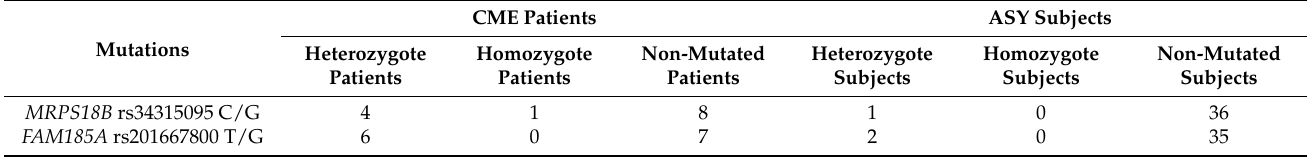
Table 2. Variants’ distribution between cases and